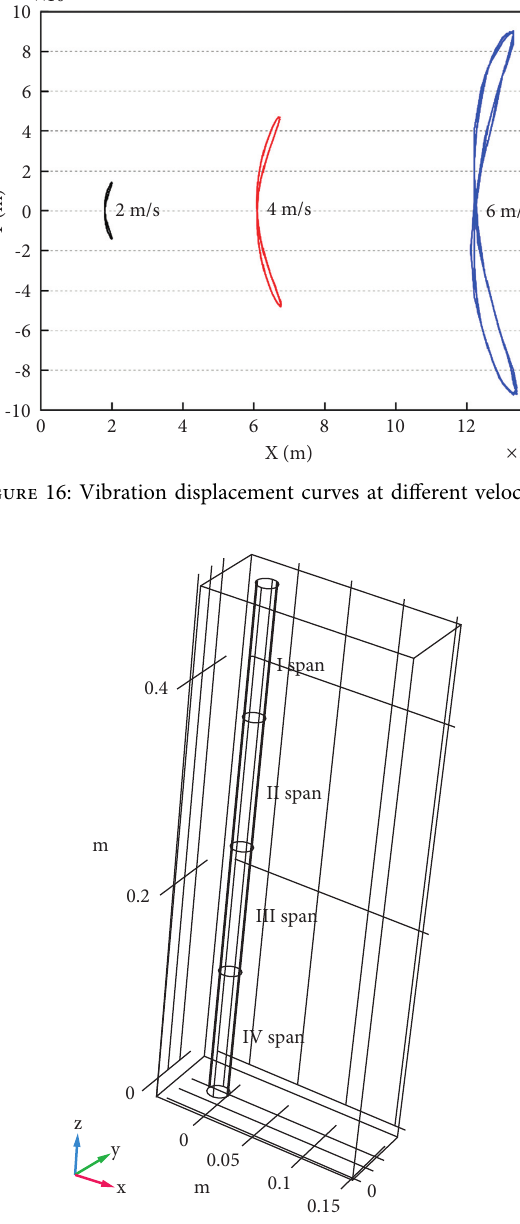
Figure 17: Four-span tube bundle model